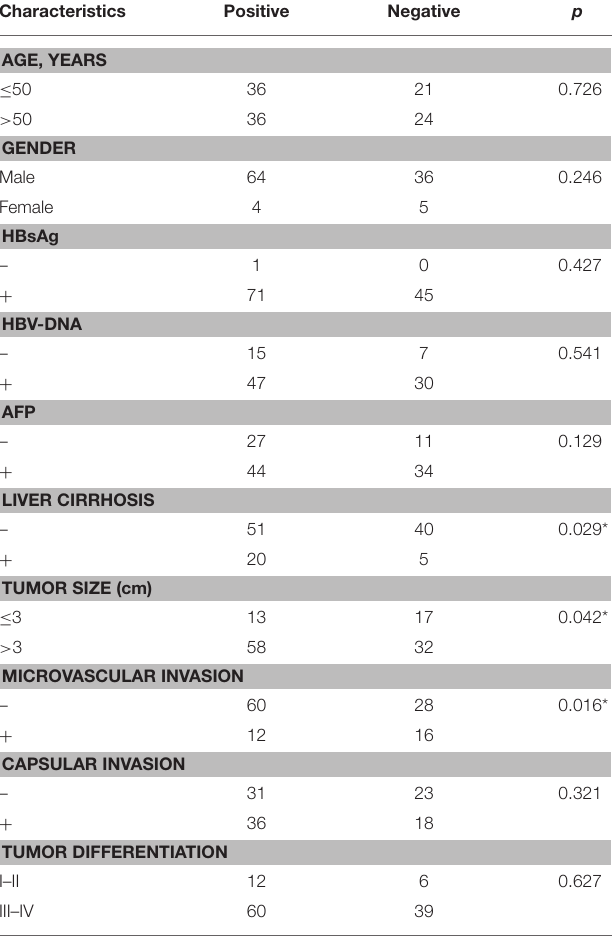
TABLE 1 | Relationship of ALCAM expression level with the clinicopathological features in HCC. Characteristics